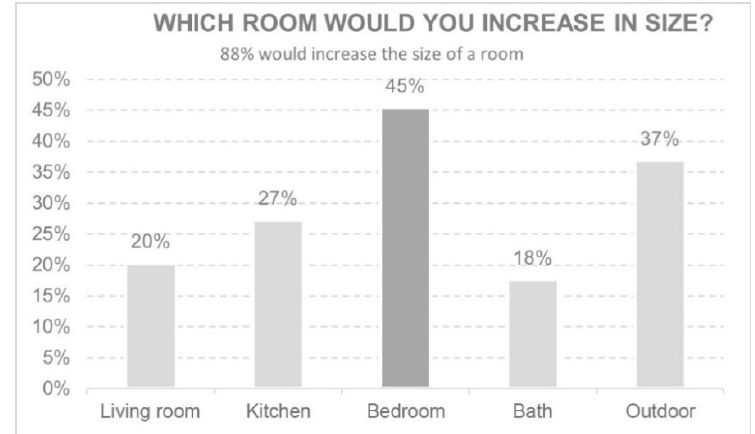
Figure 11. Which room would you increase in size?